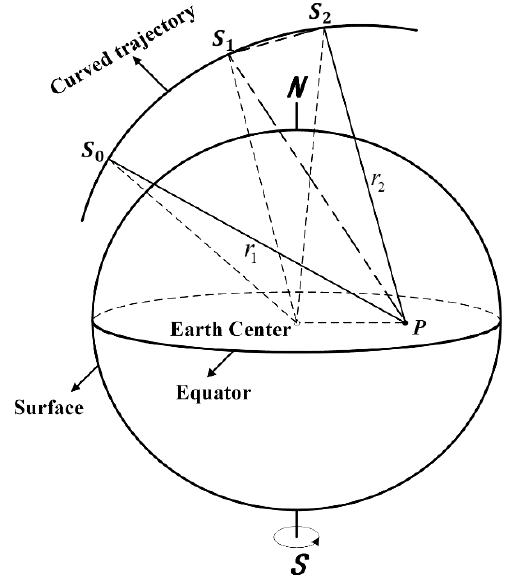
Figure 1. GEO SAR pulse propagation model in the ECEF coordinate system. P is a point target on the earth, S 0 is the satellite position when the pulse is transmitted, S 1 is the satellite position when the pulse reaches the target, S 2 is the satellite position when the pulse is received. r 1 and r 2 represent the propagation distance of pulse transmission and reception, respectively.